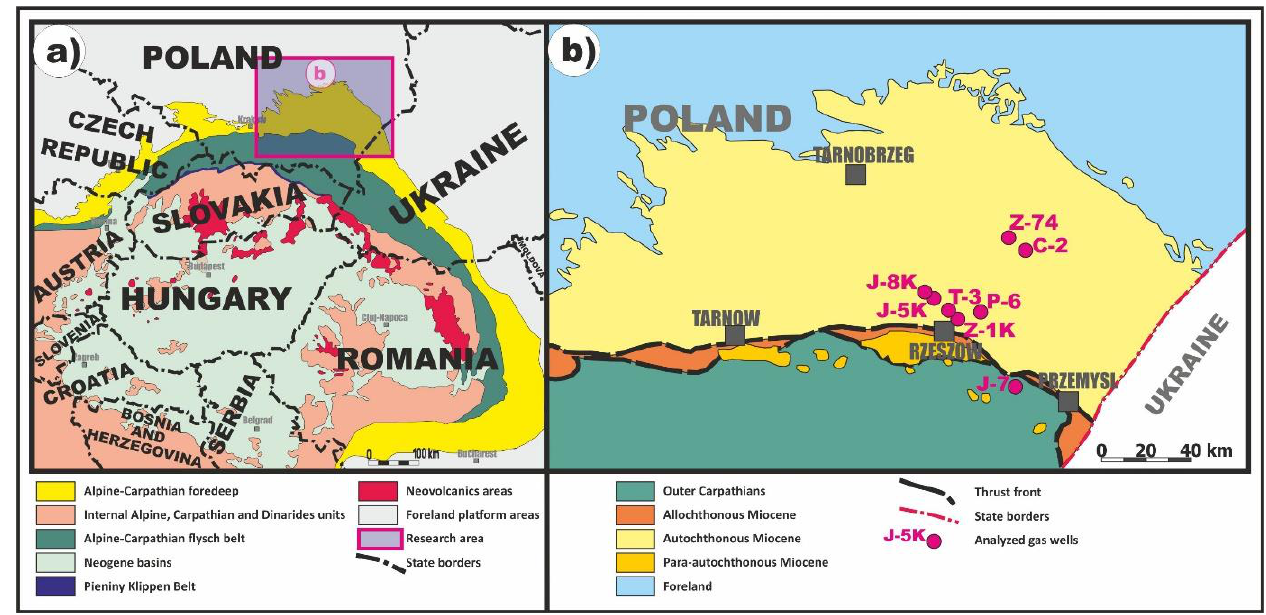
Figure 1. ( a ) Location of the study area in relation to the Carpathians and the Pannonian Basin System (PBS) (after Kováč et al., [13]; Golonka et al., [14]); ( b ) location of the analysed gas wells against the range of the eastern part of the Carpathian Foredeep in Poland; ranges of geological units according to Porębski and Warchoł [15].